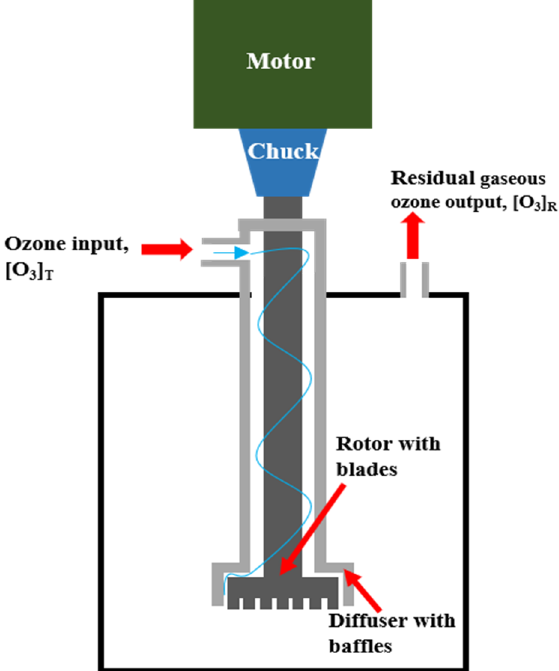
Figure A1. Diagram summarizing the system under which experiments were carried out. Extracted and adapted from [14].